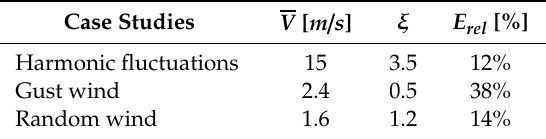
Table 2. Wind settings and comparison between Betz and OCBM energy